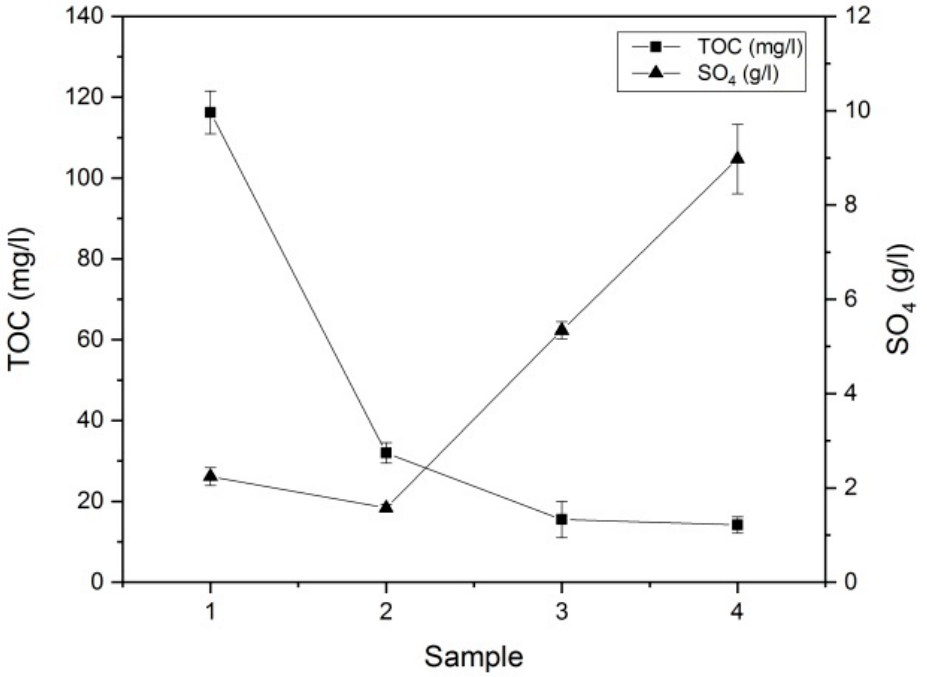
Figure 4. Variation in TOC and SO 42 − depending on samples (Sample 1: 0.1% Al 2 (SO 4 ) 3 without Cu 2+ , Sample 2: 0.1% Al 2 (SO 4 ) 3 with Cu 2+ , Sample 3: 0.3% Al 2 (SO 4 ) 3 with Cu 2+ , Sample 4: 0.5% Al 2 (SO 4 ) 3 with Cu 2+ ).